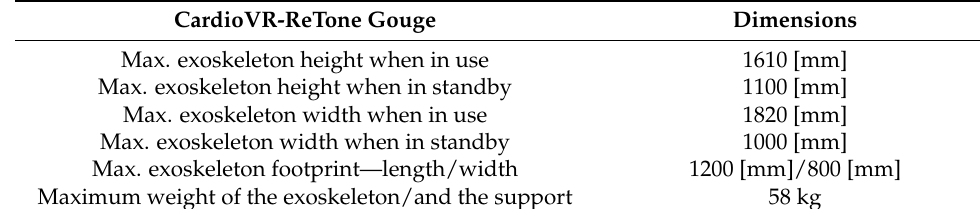
Table 1. Technical characteristic of CardioVR-ReTone.